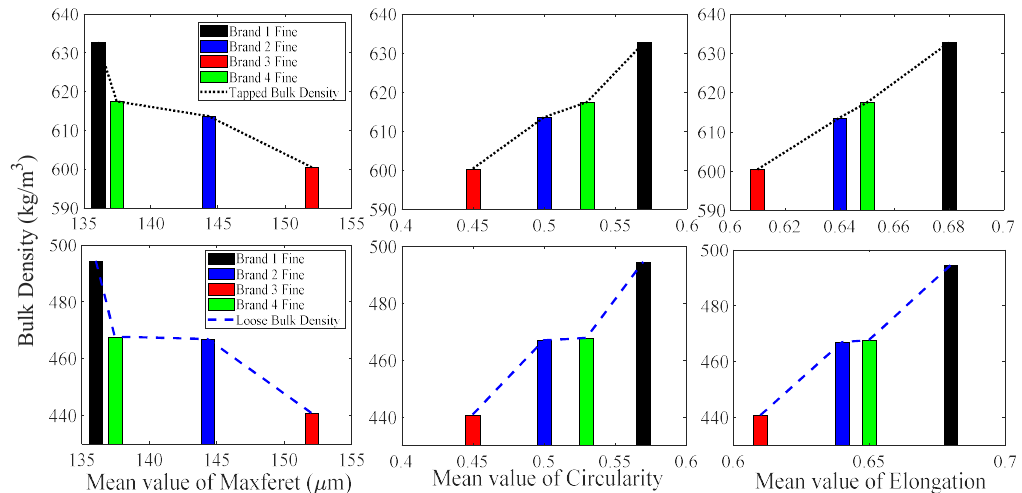
Figure 5. Tapped and loose bulk density from four different brands of instant whole milk powder versus mean values of shape factors for fine particles.